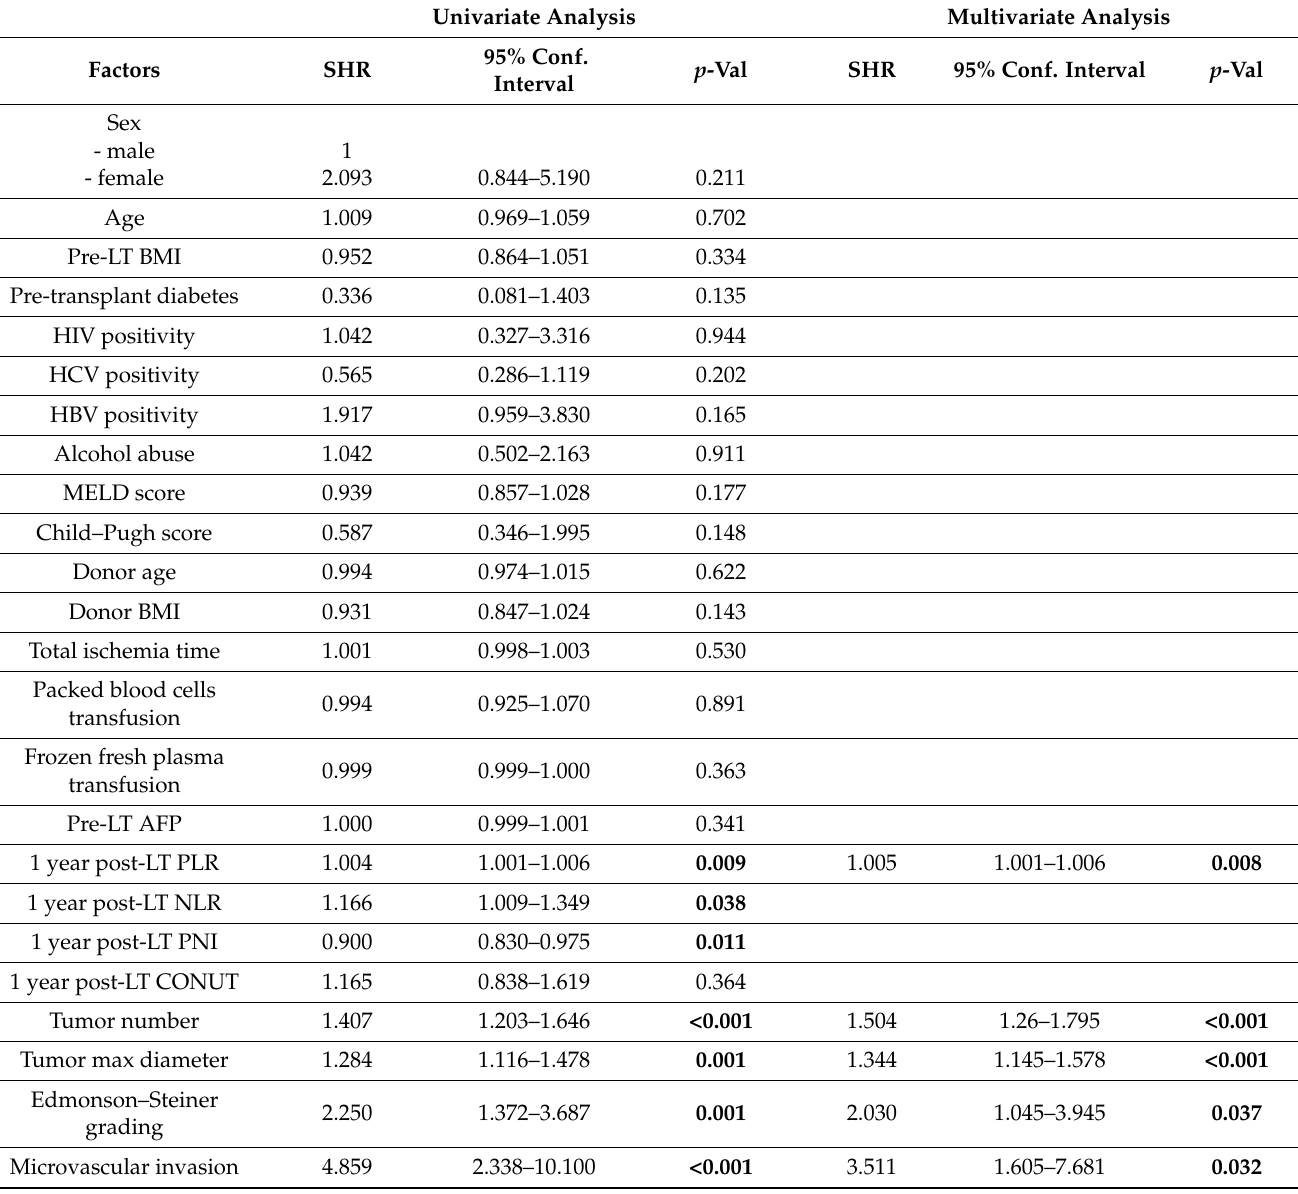
Table 4. Univariate and multivariate analysis of prognostic factors for HCC recurrence, in subgroup analysis of patients with OS > 1 year and no early HCC recurrence ( n = 266). Univariate Analysis Multivariate